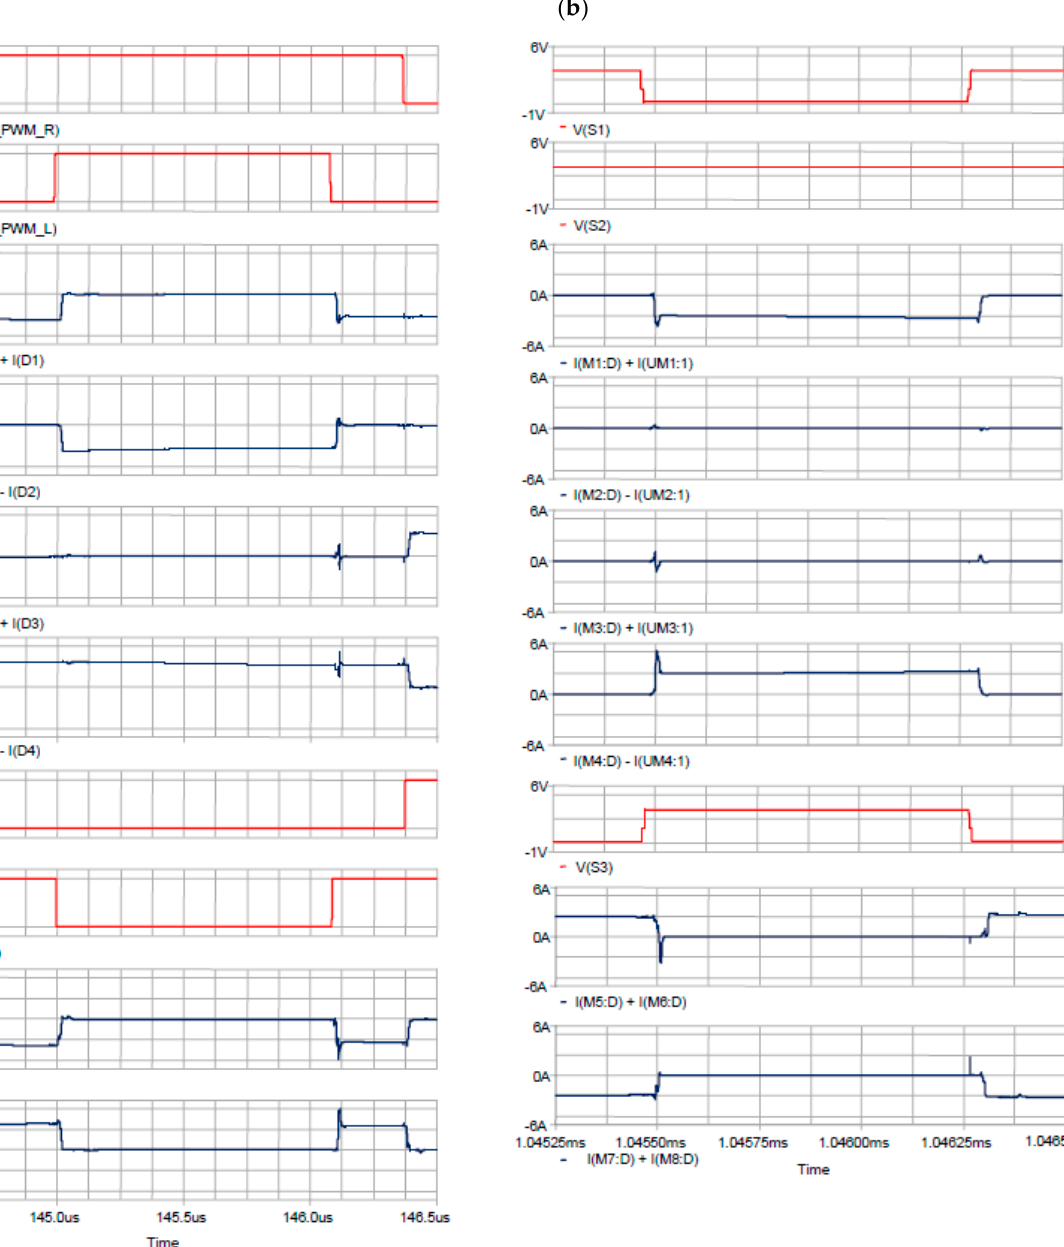
Figure 6. Time waveforms of the PWM control signals generated in one selected period T c , and the drain currents of the power MOSFETs in the circuits shown: ( a ) in Figure 4, ( b ) and Figure 5, respec ‐ tively.